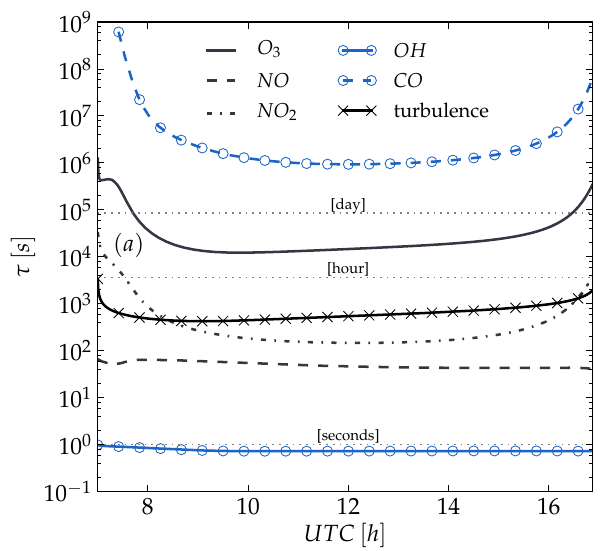
Fig. 7. Lifetimes of key chemical species and the convective